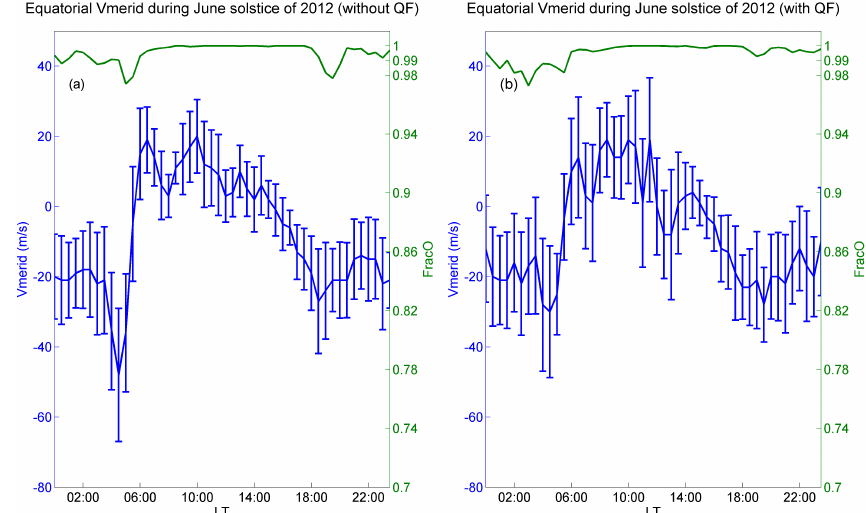
Figure 4. The median equatorial Vmerid (vertical drift velocity) and fraction of O + obtained from C/NOFS during (a) non-QF days and (b) QF days in June solstice (May–August 2012) at 102–116 ◦ E longitude and 5 ◦ S–5 ◦ N magnetic latitude.